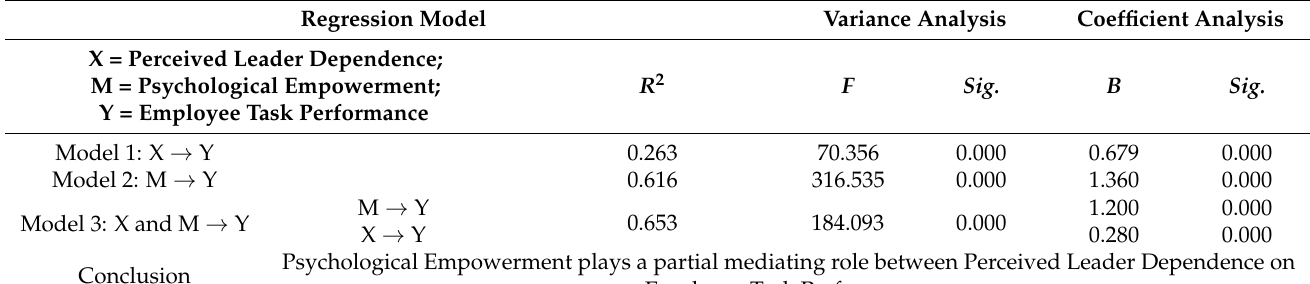
Table 22. Test of the Mediating Effect of Psychological Empowerment between Perceived Leader Dependence and Employee Task